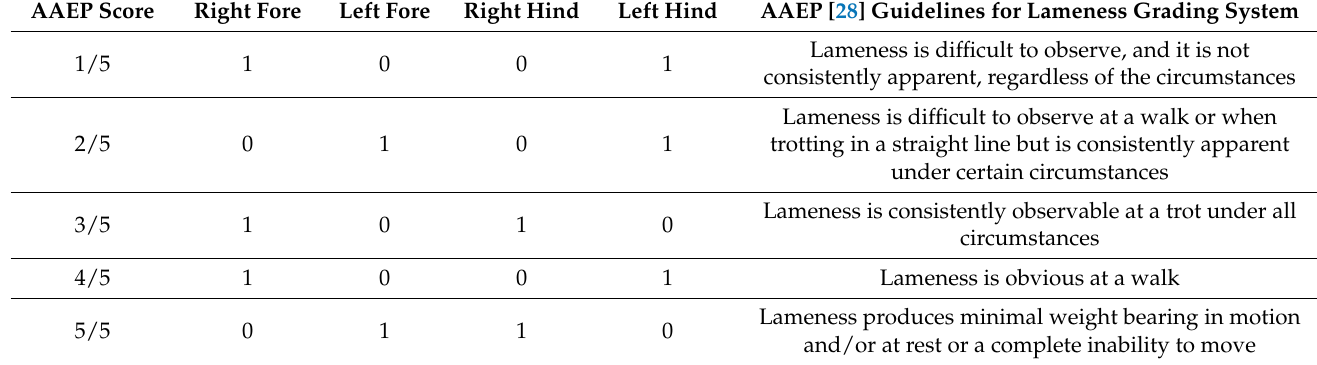
Table 1. The diagnosed AAEP scores and their prevalence in the studied horses ( n = 10), according to their lame